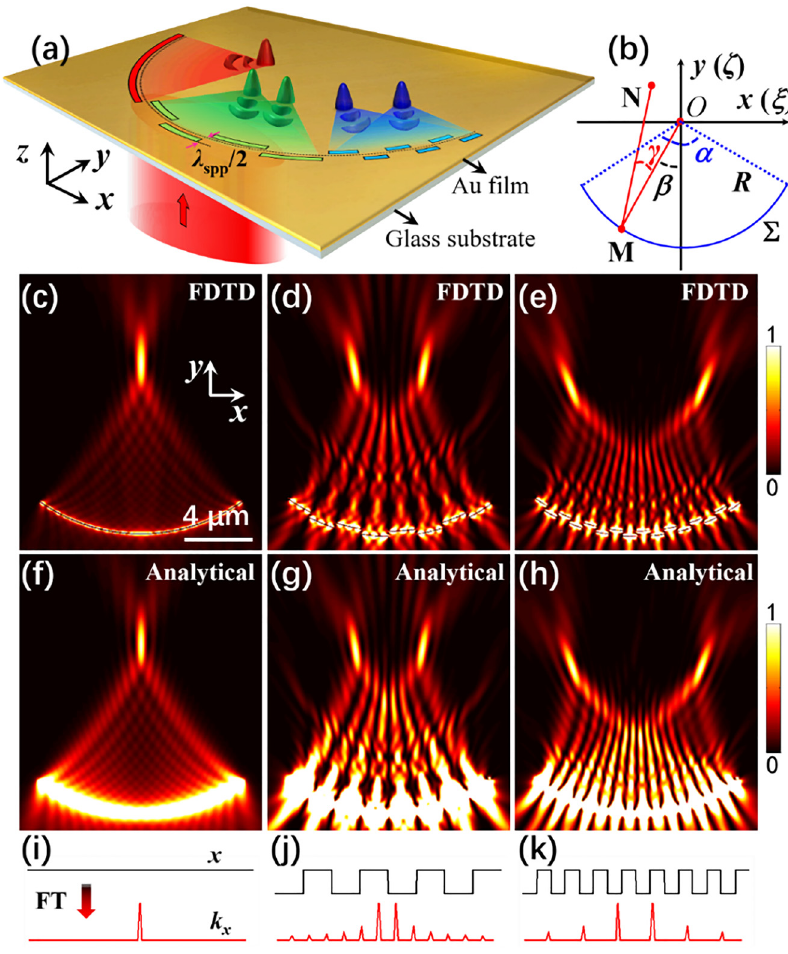
Figure 1: Principle of the on-chip plasmonic metalens. (a) Schematic diagram of the SPP focusing process excited by a plasmonic metalens structure, which is composed of a gold film (200 nm in thickness) etched with multiple discrete nanoslits (100 nm in width) around a circular reference arc (black dashed curve with a radius of R ) on a glass substrate ( λ